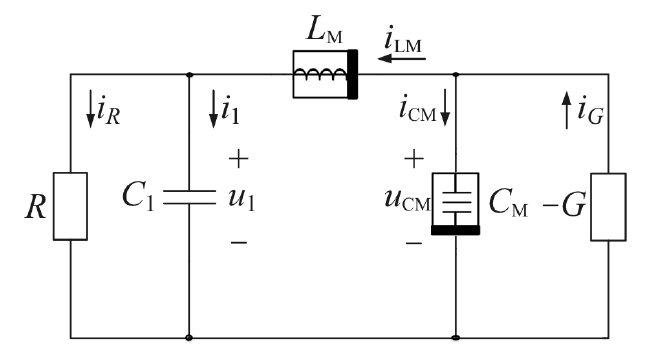
Figure 2. Chaotic oscillator circuit based on two memory elements